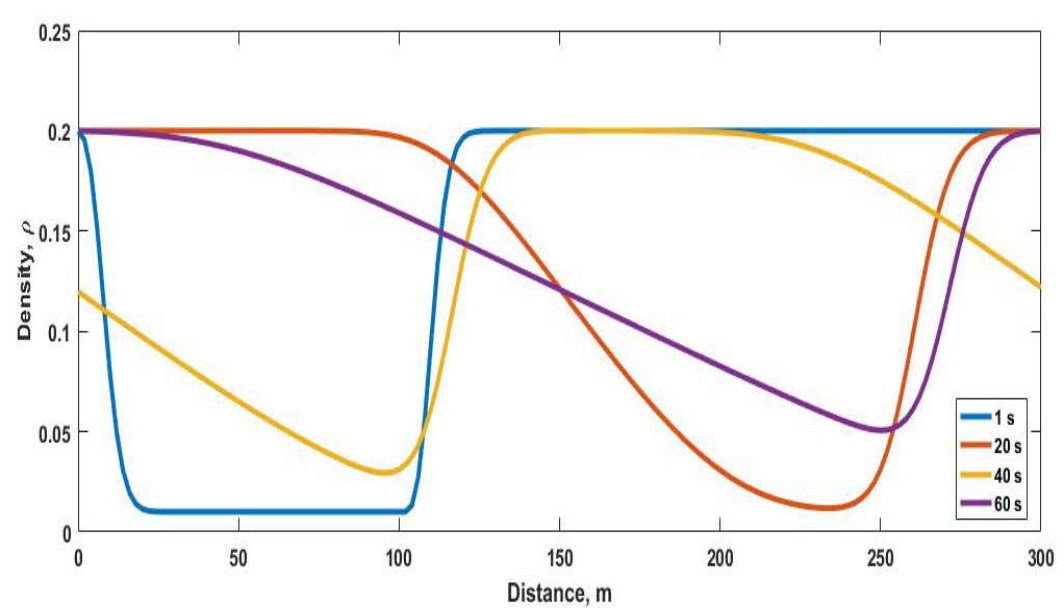
Figure 9. Density behavior with the proposed model for time step 0.01 s and road step 2 m on a 300 m circular road with h = 20 m at 1 s, 20 s, 40 s and 60 s. Table 5. Velocity and density of the proposed model for the resolution test at 1 s, 20 s, 40 s and 60 s. Time (s) Distance (m) Normalized Density Velocity